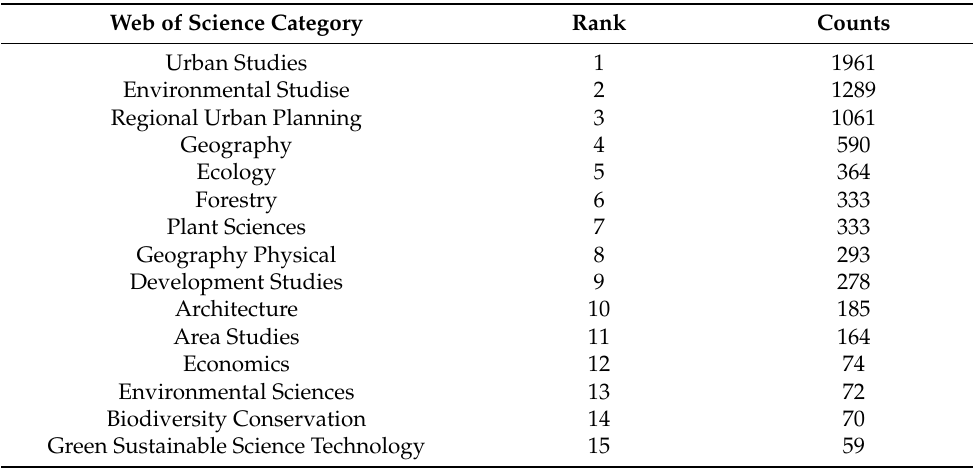
Table 2. Top 15 WOS subject categories based on publications.